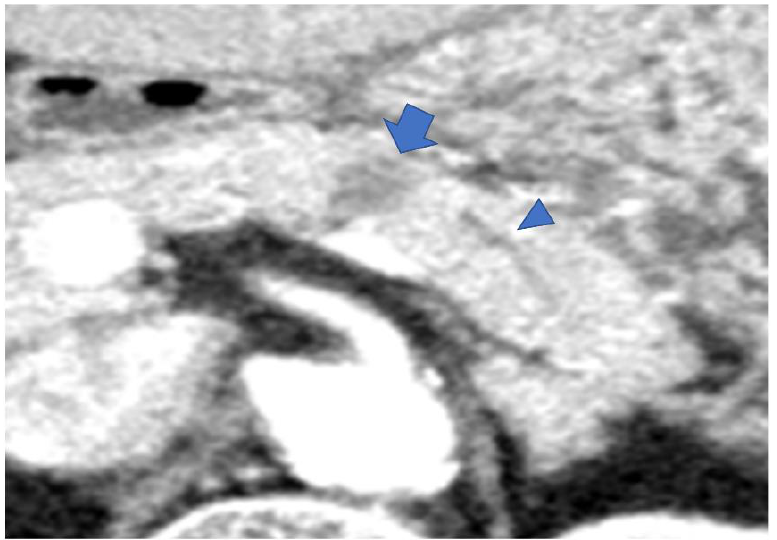
Figure 7. CECT shows an 18 mm large low-absorption area (arrow) in the pancreatic body area. MPD is not dilatated (arrowhead). MPD, main pancreatic duct.